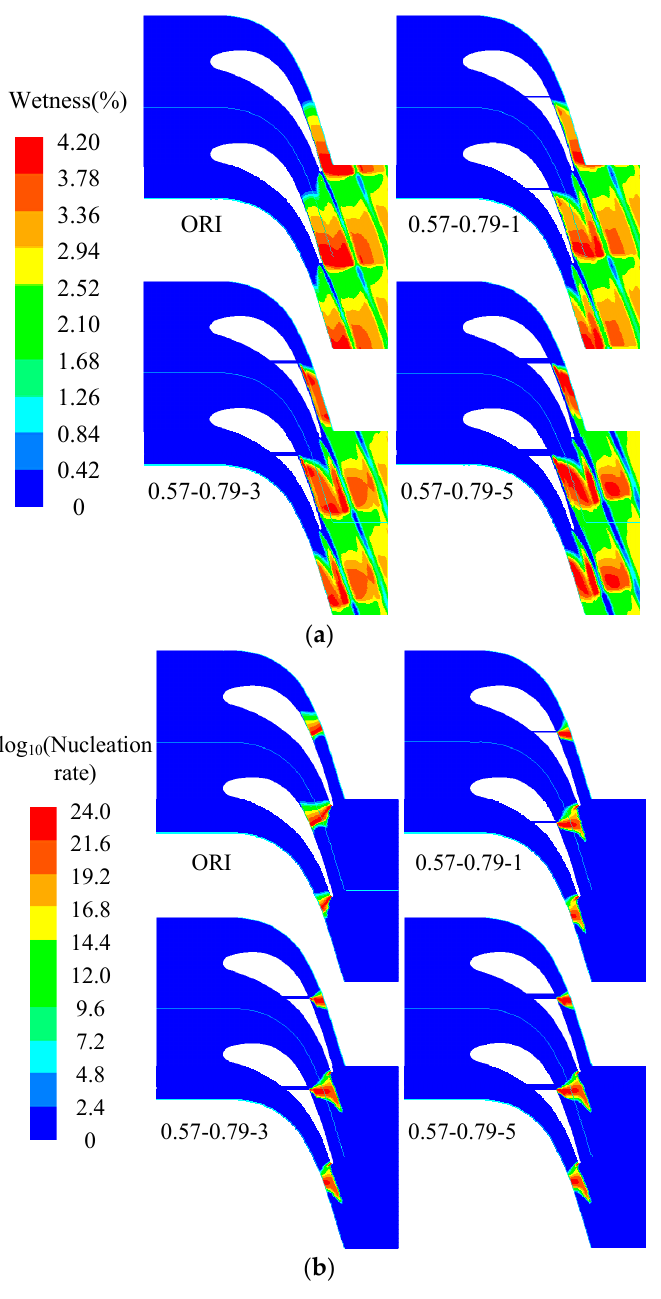
Figure 9. Distribution of ( a ) wetness and ( b ) nucleation rate (part 3).